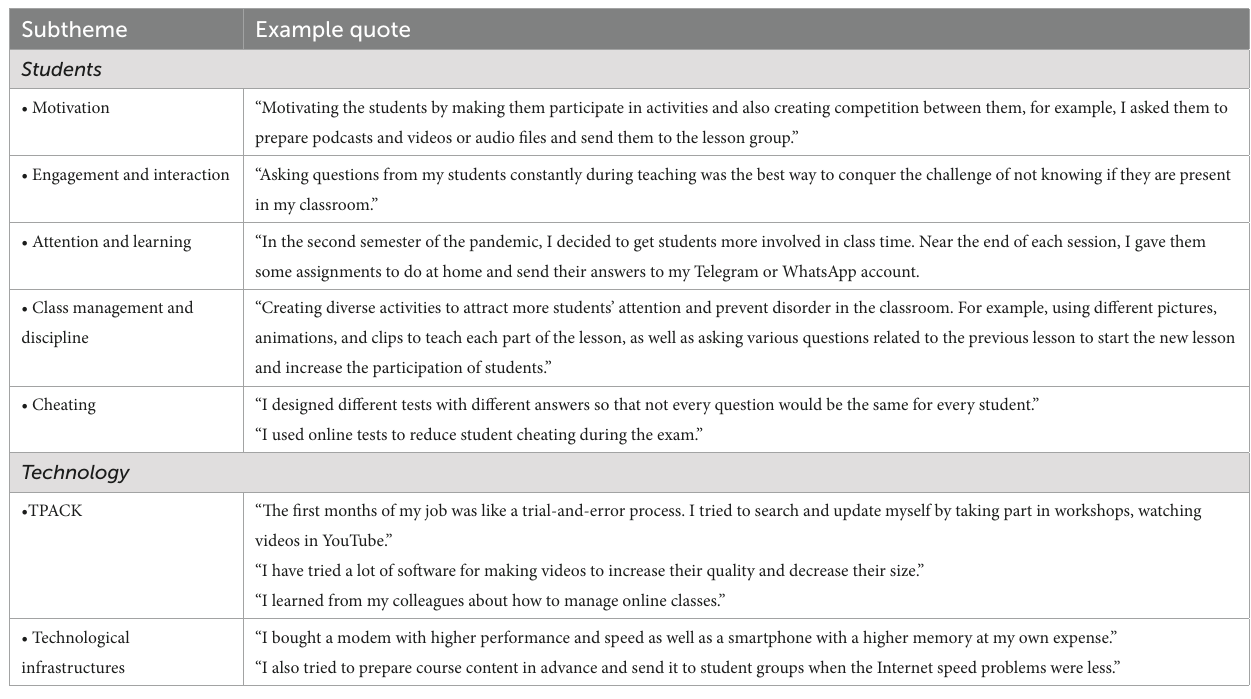
TABLE 9 Theme 2 coping mechanisms: Subthemes, categories, and example quotations.